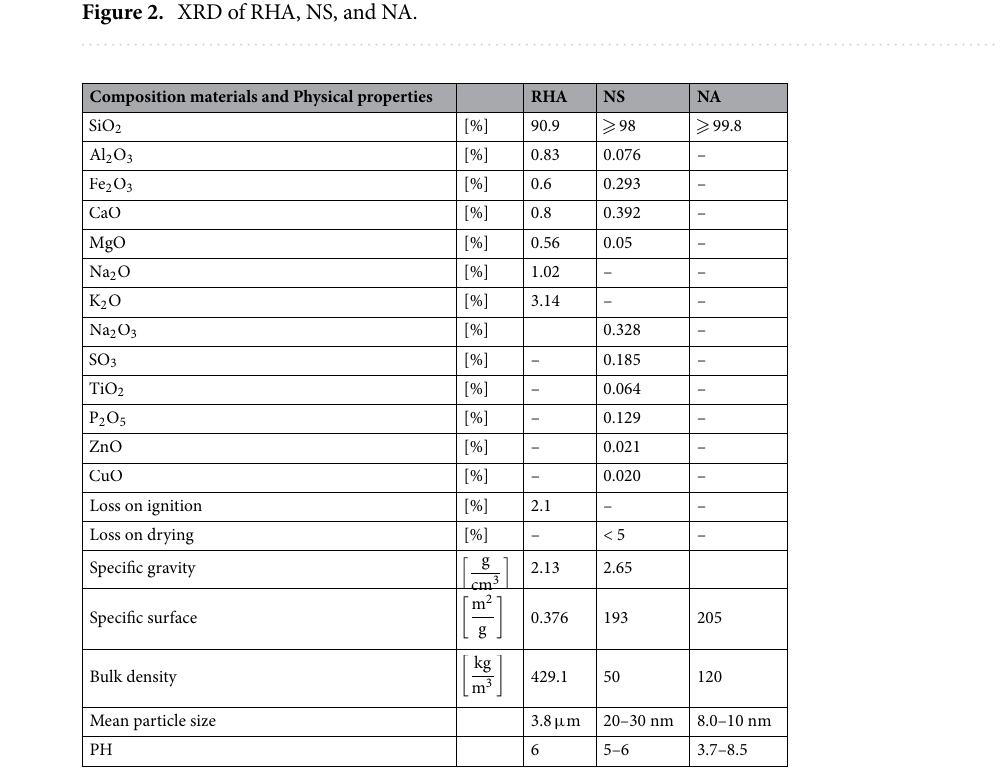
Table 3. Characteristics of RHA, NS, and